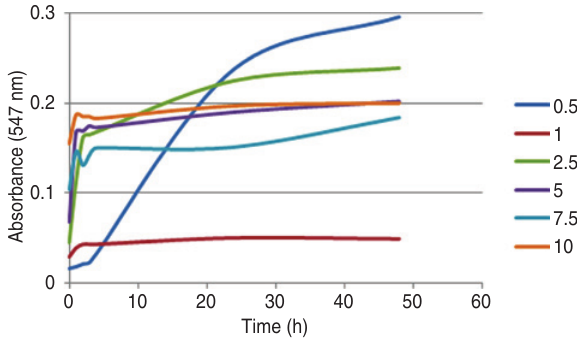
Figure 6: The effect of HAuCl4 concentration on the synthesis of gold